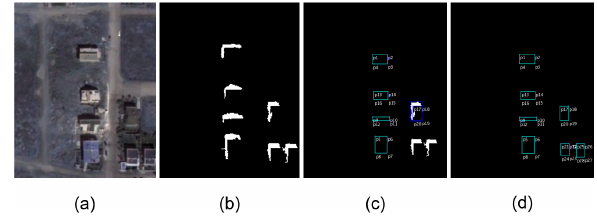
Figure 2. The implementation of the developed algorithm for architectural documentation. First test image, (a) QuickBird pan-sharped image (R,G, B and INR), (b) the extracted shadow regions after removing the small unwanted areas, (c) the extraction of the building geometry, (d) the location and shape of the detected